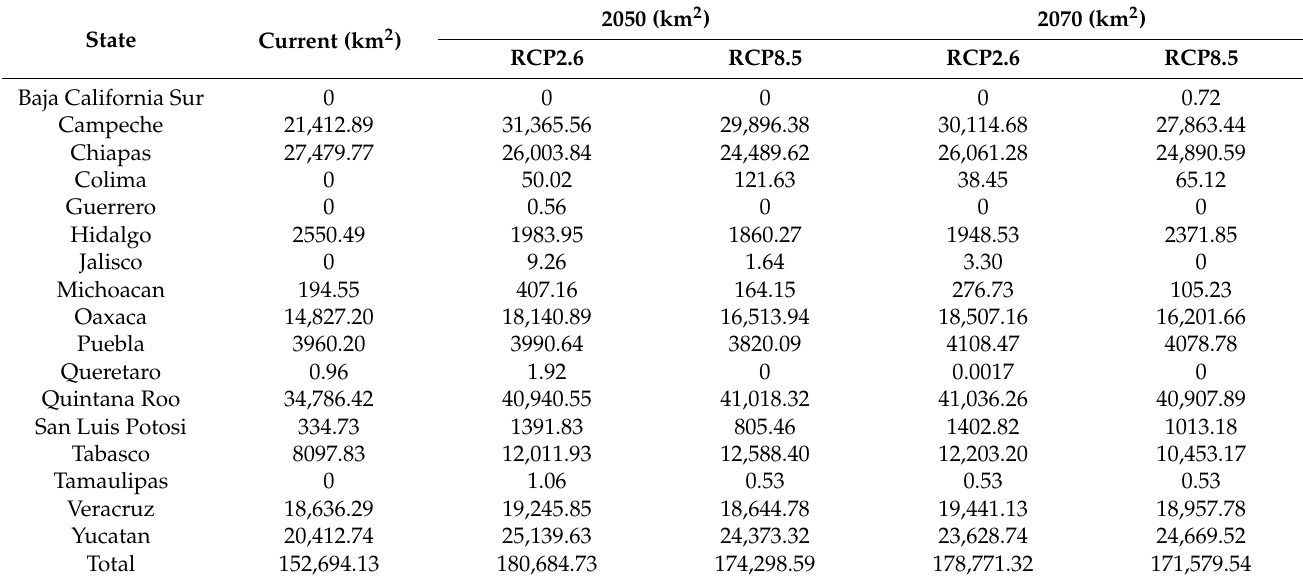
Table 2. Current and predicted area (km 2 ) by state where S. macrophylla populations could be present based on climate change scenarios according to the CCSM4